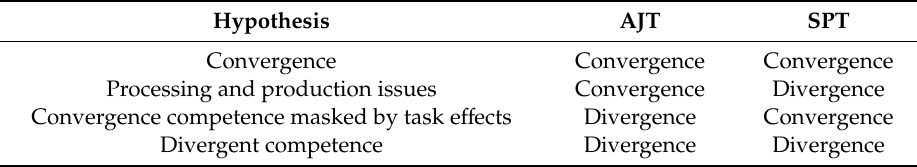
Table 4. Hypotheses and relevant predictions for each